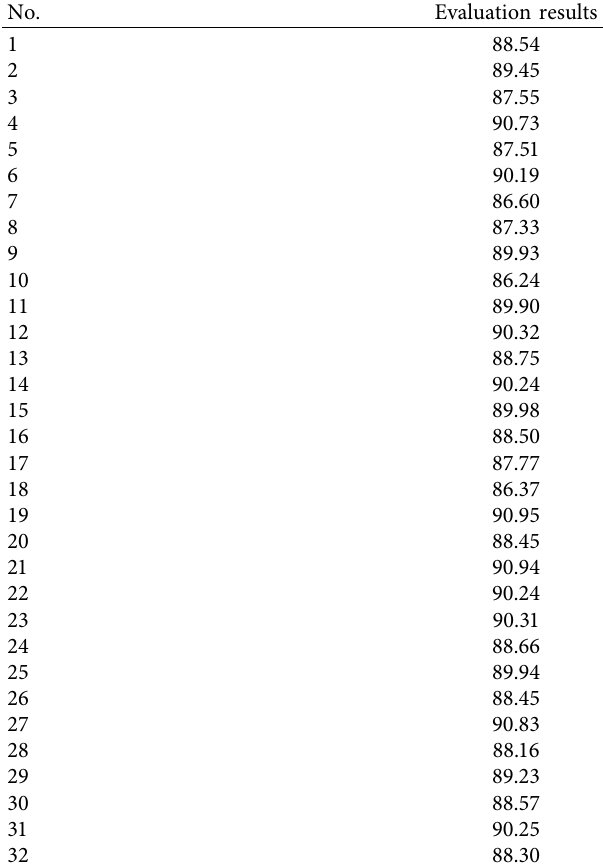
Table 1: Evaluation of high-speed railway communication strategy based on LIFI technology.